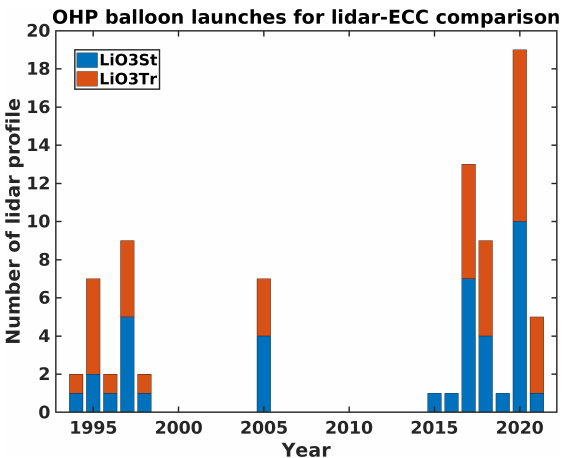
Figure 3. Time distribution of the number of OHP lidar observa- tions per year with a time lag between ECC launches and lidar mea- surement < 2h (LiO3Tr) or < 6h (LiO3St). These observations are used for the lidar–ECC comparison of Figs. 5 and 6. The blue bars correspond to LiO3St measurements and red bars to